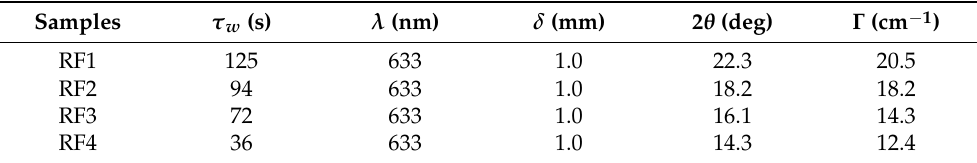
Table 3. Table 3. Experimental results of two-wave coupling of exponential gain coefficient of Sc:Ru:Fe:LiNbO 3 crystal. Sc:Ru:Fe:LiNbO 3 crystal.